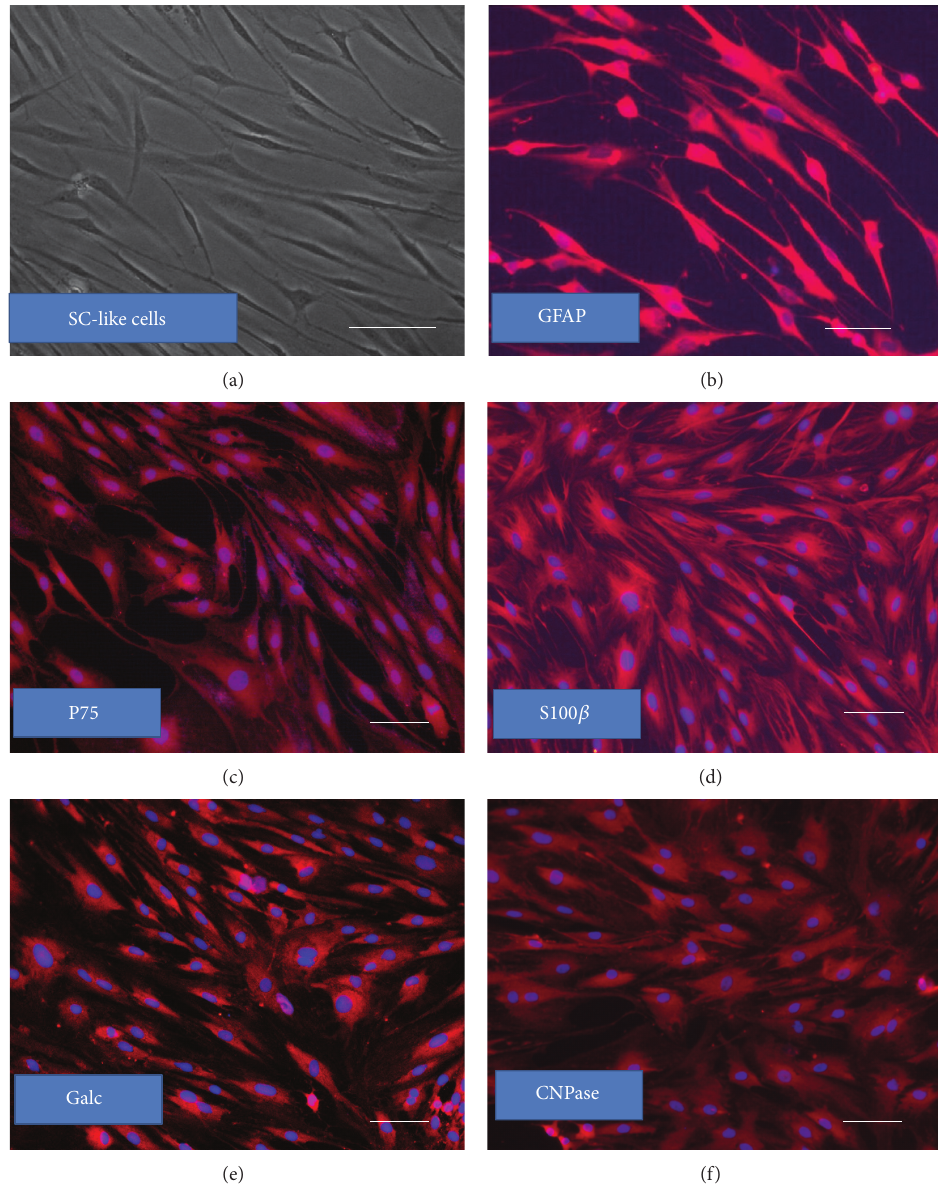
Figure 3: SC-like cells differentiated from REMSCs demonstrated typical Schwann cell morphology and were labeled with related cell surface markers. After 10 days, cells appeared typical bipolar and spindle-like Schwann cell phenotype (a), immunofluorescent staining showed that differentiated cells were stained positively with GFAP (b), P75 (c), S100 𝛽 (d), Galc (e), and CNPase (f). Nuclei were labeled with Hoechst 33342 (blue). Bar: 50 𝜇 m for all